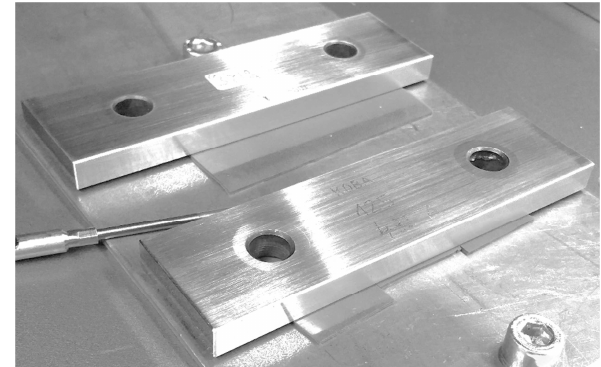
Figure 5. The workpiece (upper) and the reference workpiece (lower) on the CMM’s table in example